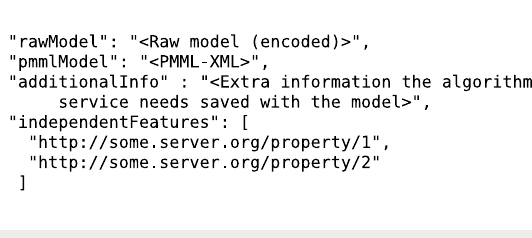
Upon training, the model returned to the caller is stored as-is by the called service and will be returned back to the JPDI- compliant service when the client requests a prediction. This way, as already mentioned, the JPDI service providers do not need to maintain a database while the eNanoMapper services do not need to know how the third-party services perform compu- tations. Likewise, when Jaqpot Quattro needs to consume a JPDI web service to perform predictions, it POSTs to it a JSON document with (i) the input dataset containing substances and (ii) the model that was previously created by the JPDI service. An example of JSON prediction request is shown in Figure